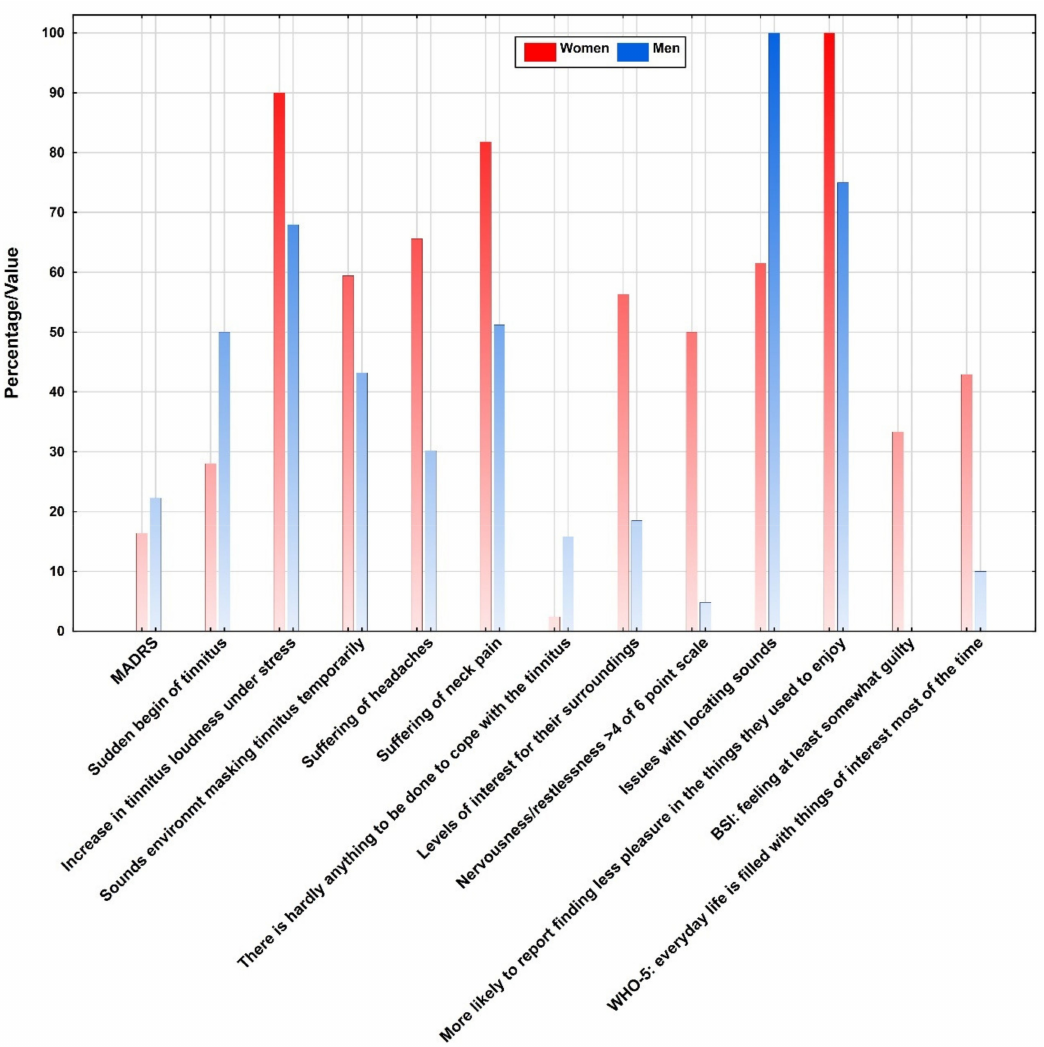
Figure 1. Overall percentage distribution of the statistically significant psychometric outcome variables collected in the total